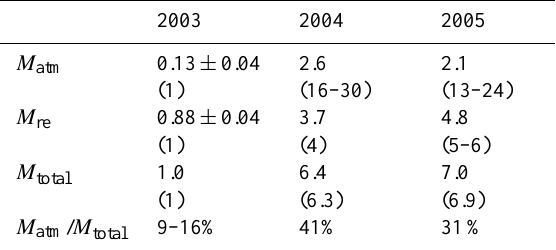
Table 1. Temporal variations in the export flux per unit area of the catchment (mmolm − 2 yr − 1 ) of atmospheric nitrate ( M atm ) , together with those of remineralized nitrate ( M re ) , total nitrate ( M total ) , and M atm / M total ratio. Changes relative to 2003 are pre- sented in